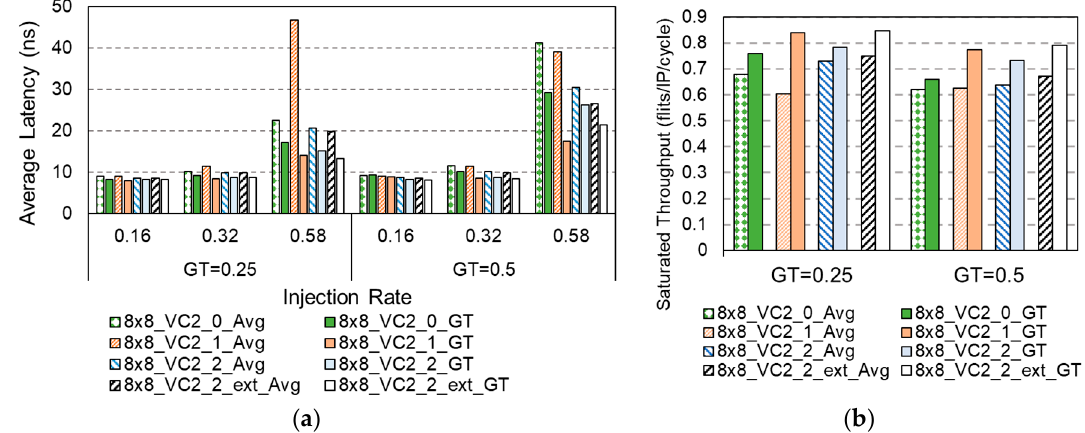
Figure 8. Performance comparison of three VC configurations at various injection rates and GT values: ( a ) average latencies and ( b ) saturated throughputs.